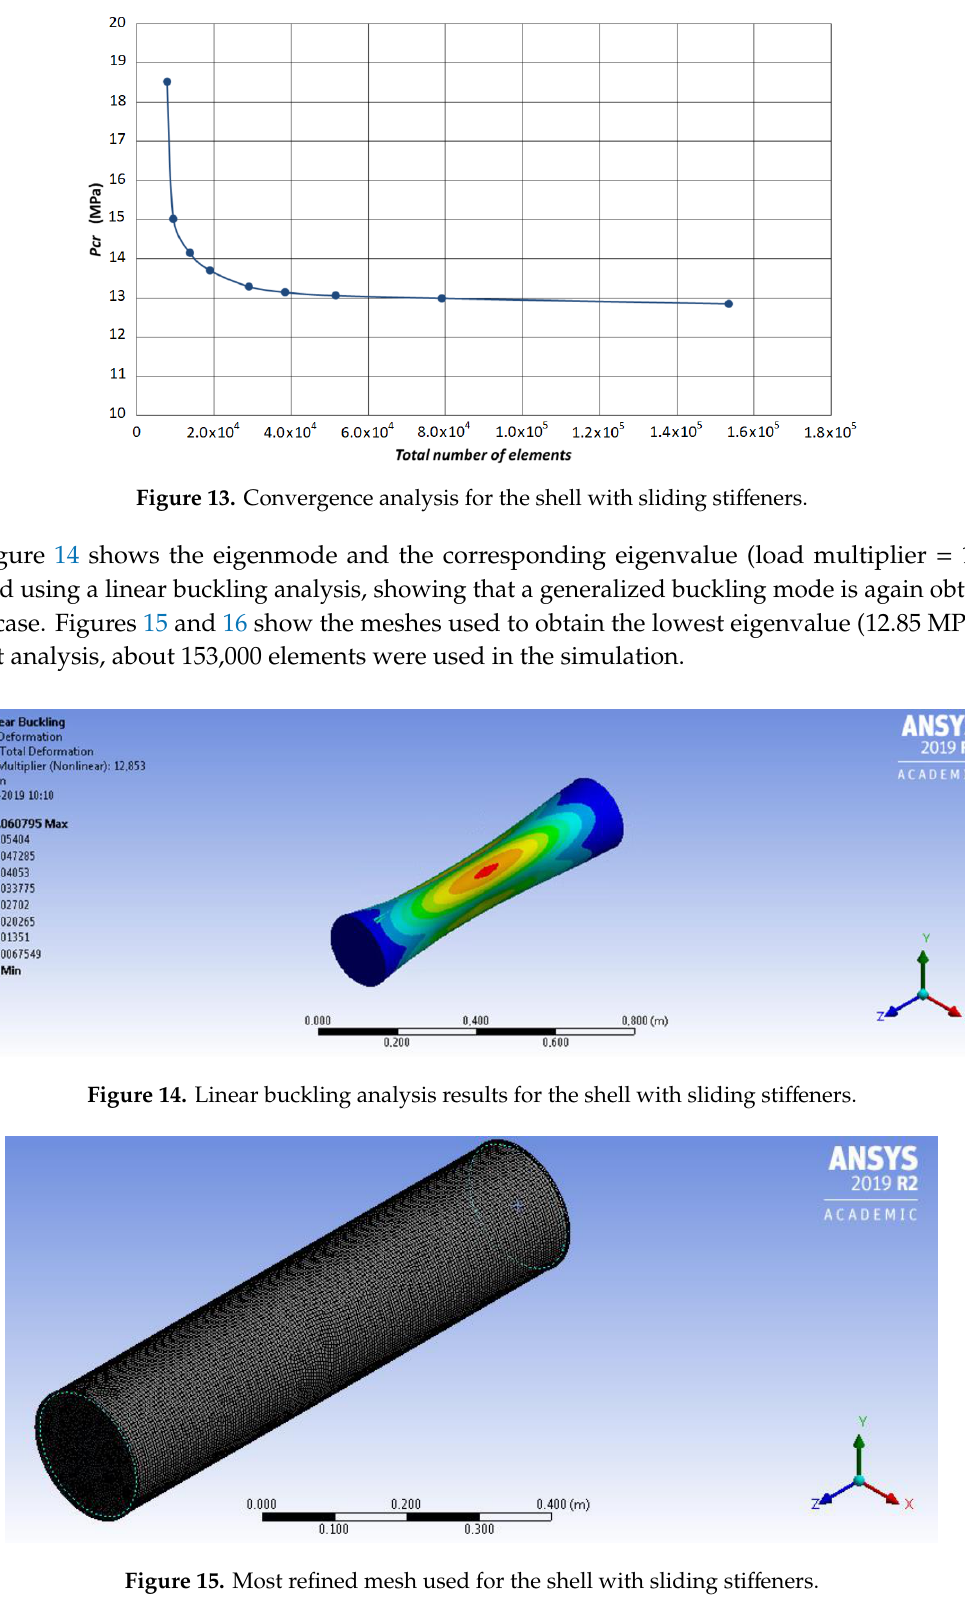
Figure 16. Most refined mesh used for the shell with sliding stiffeners: front view of the stiffening members. Figure 17 compares the finite element results obtained for the critical buckling pressures considering the three studied cases: (i) the unstiffened shell case (Section 2), (ii) the conventional stiffened shell case (Section 3), and (iii) the shell with sliding stiffeners case (Section 4). It can be noticed that the solution provided by the sliding stiffeners added several advantages to the AUV design: ease of manufacture (since the ring stiffeners are not welded to the shell), reduction of the manufacturing cost (by the same token), and increase in the buckling strength of the structure, meaning a direct increase in the water depth at which the vehicle can operate.